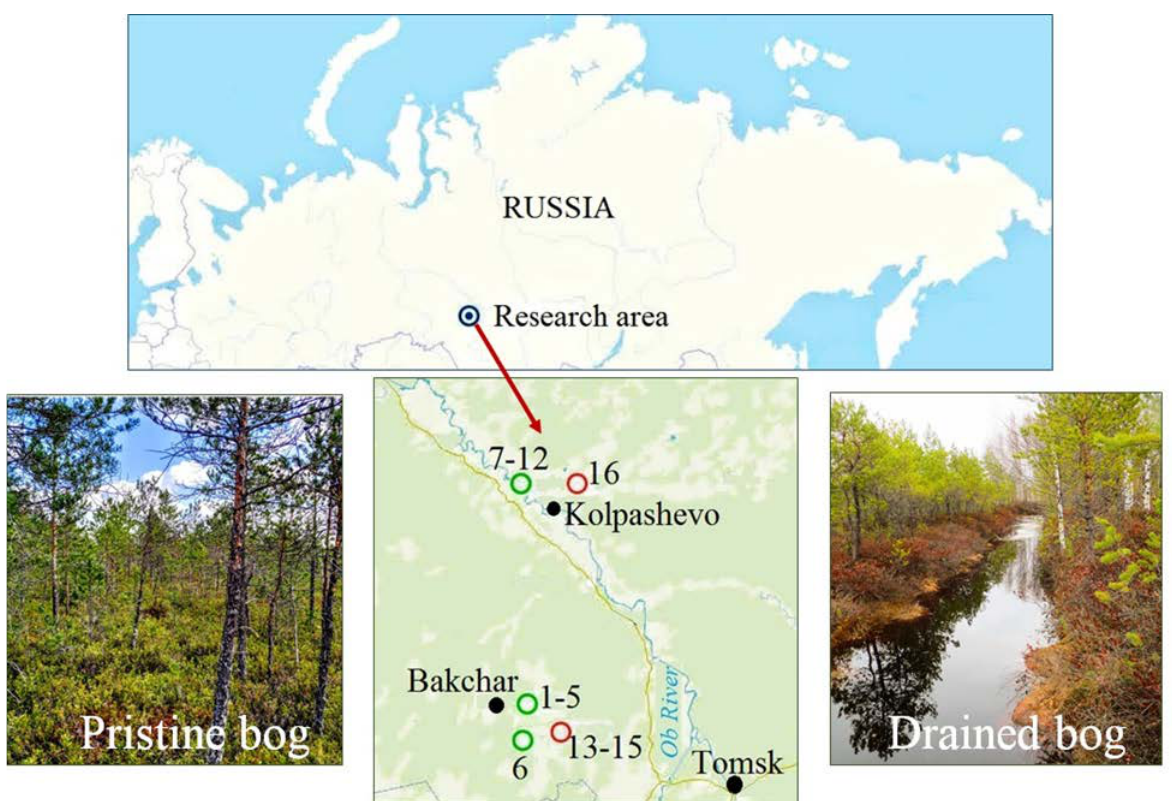
Figure 1. Location of the study area. Sites 7–12 and 16: terrace of the Ket River; Sites 1–6 and 13–15: Vasyugan mire. Green symbols indicate pristine areas and red symbols denote drained